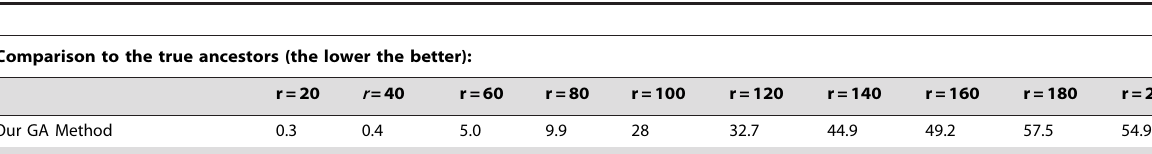
Table 2. Comparison of the breakpoint distance from the inferred median to the true ancestor.